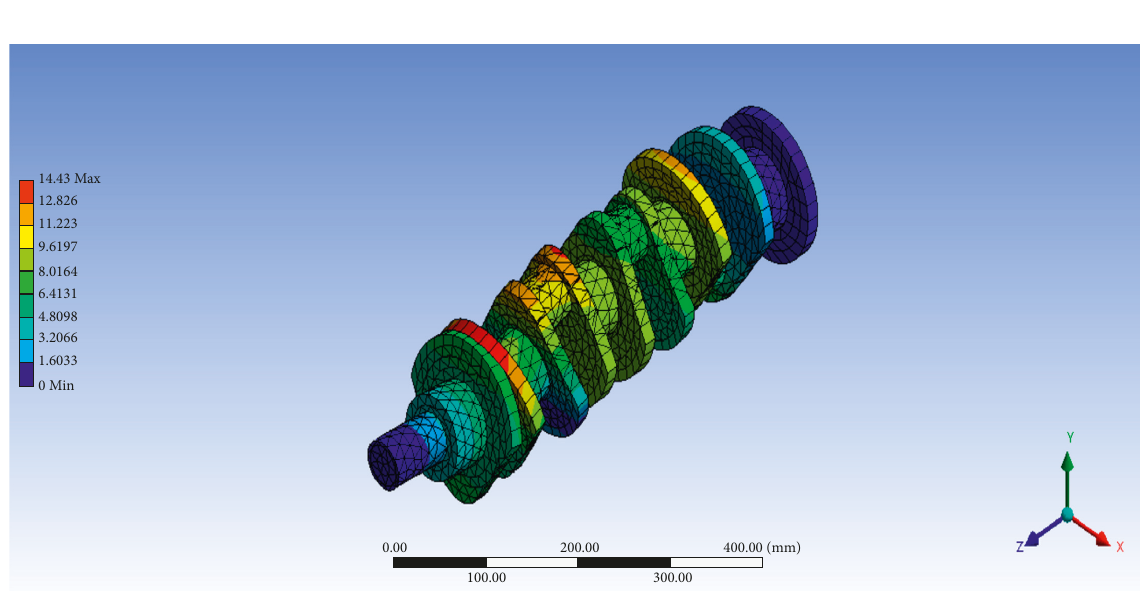
Figure 19: Deformation of FGM crankshaft at the third mode of